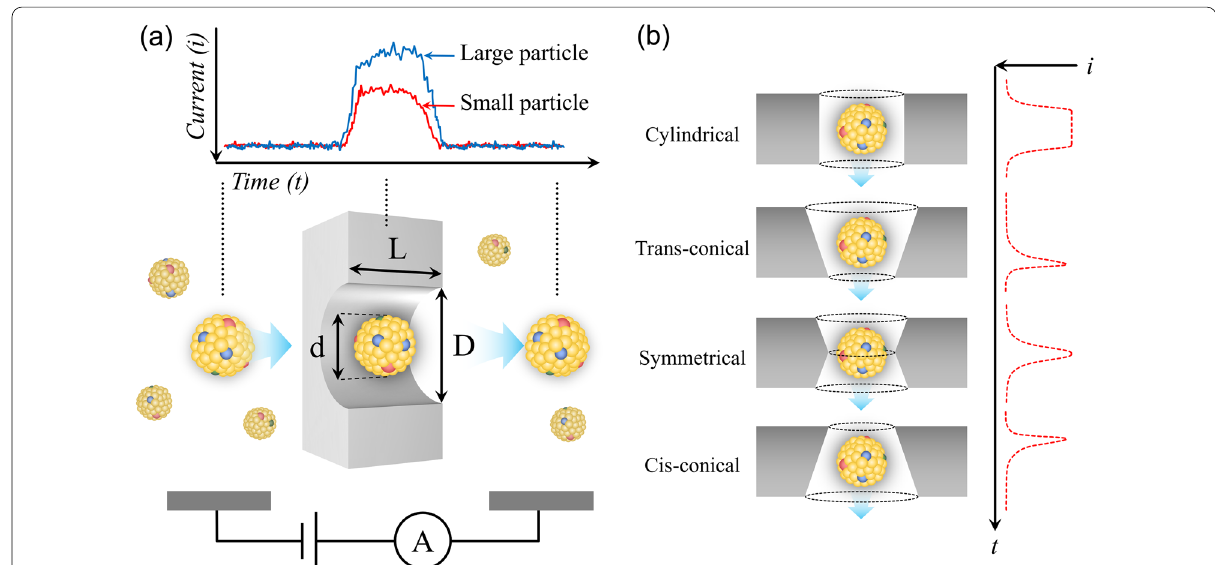
Fig. 6 Schematic diagram of resistive pulse sensing (RPS). a Measurement principle of RPS and signals of particles passing through the pore. b Acquired signal profile according to the morphology of the pore by